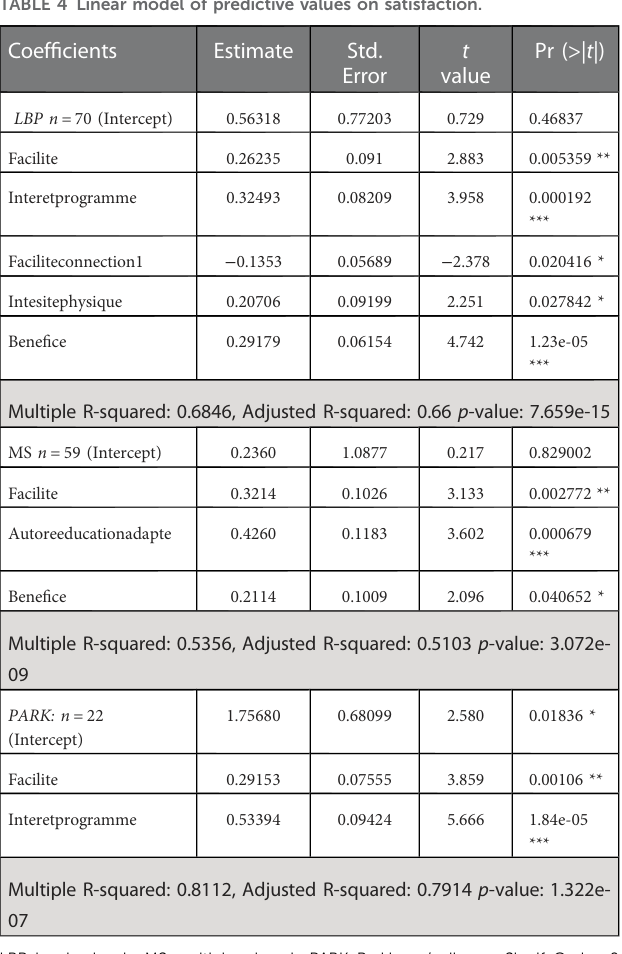
TABLE 4 Linear model of predictive values on satisfaction.